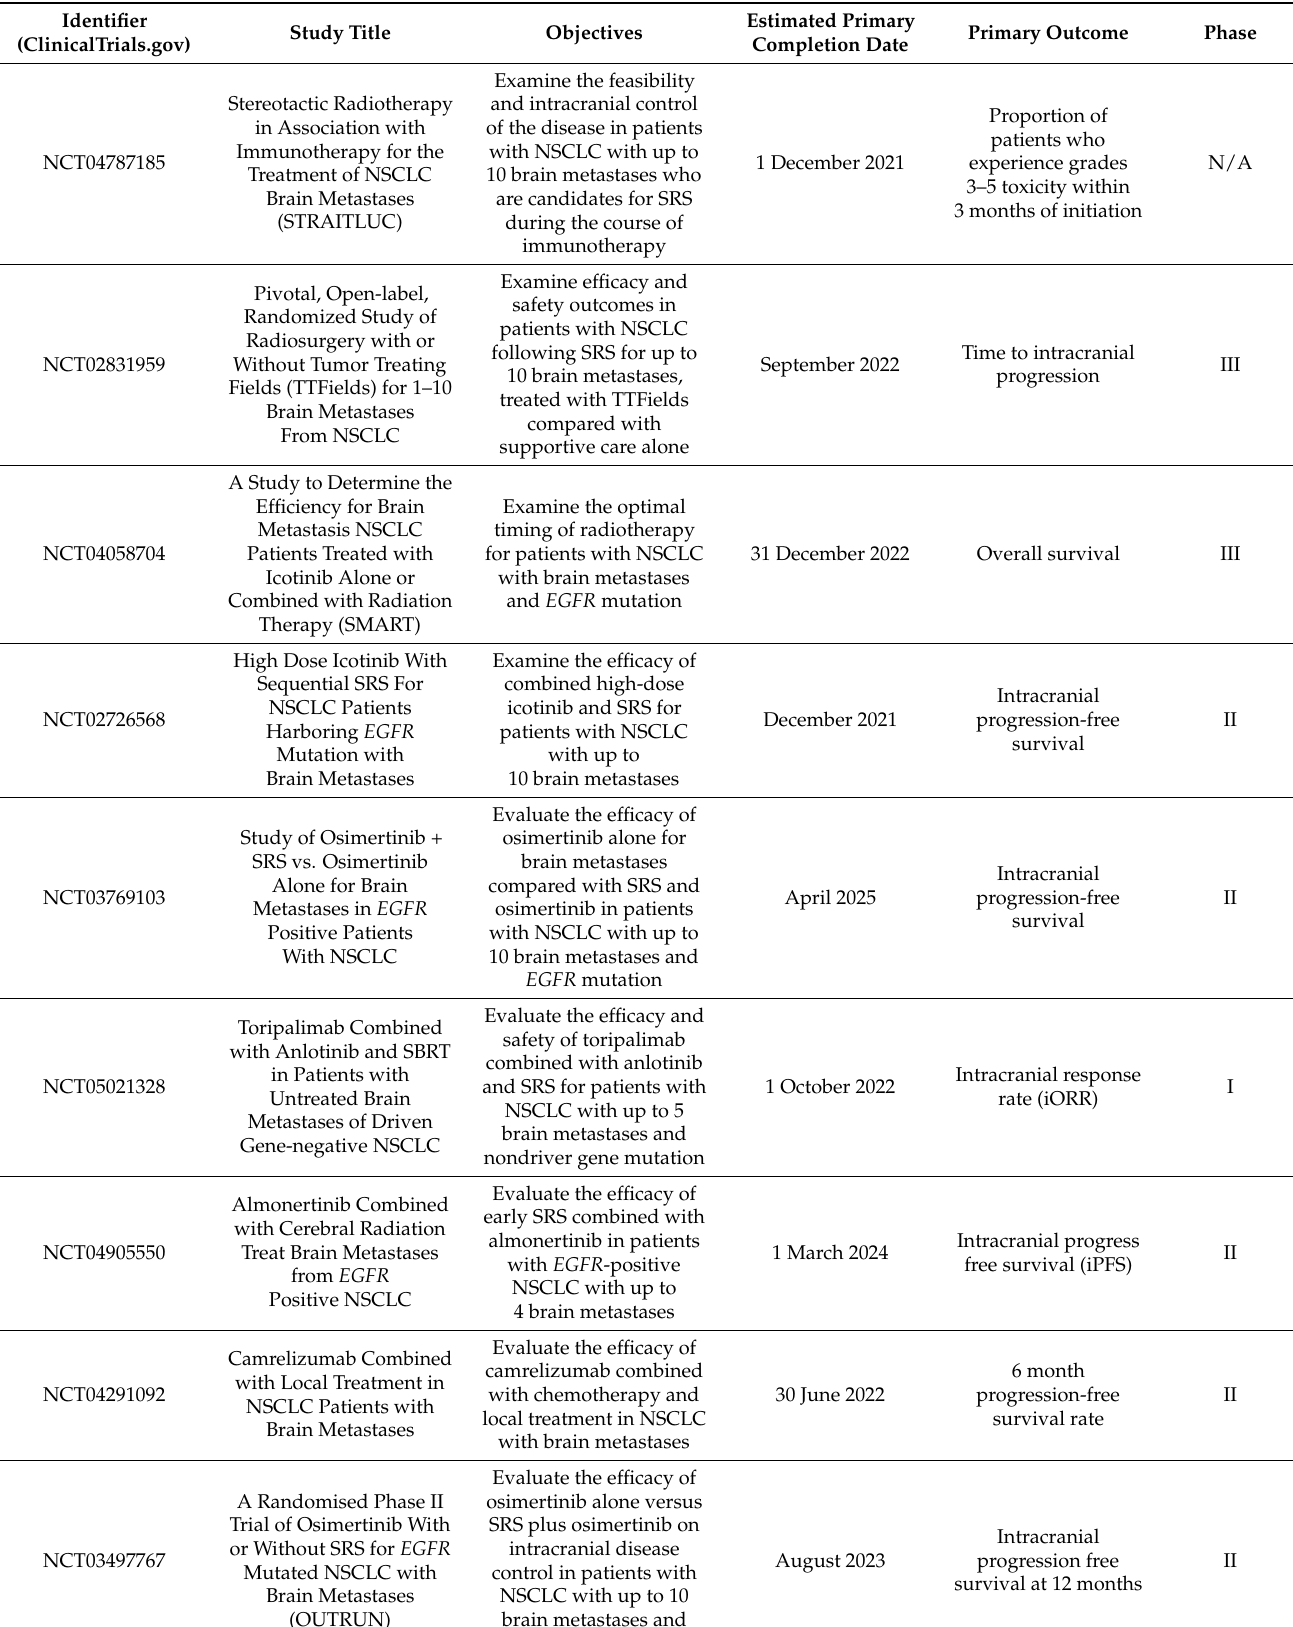
Table 1. Ongoing trials of interventions for NSCLC patients with brain oligometastases (https: